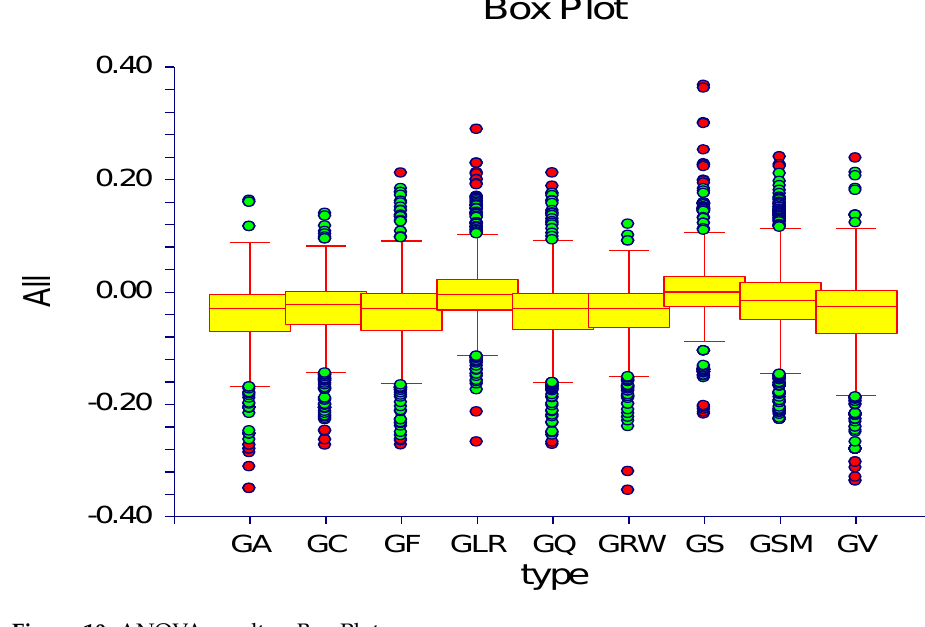
Figure 10. ANOVA results—Box Plot.